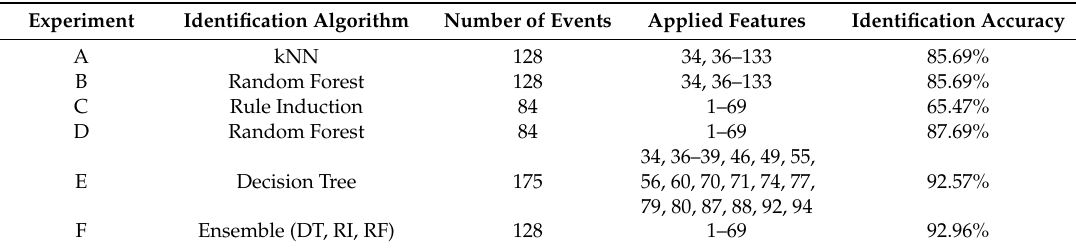
Table 4. Overall identification accuracy for several algorithms.